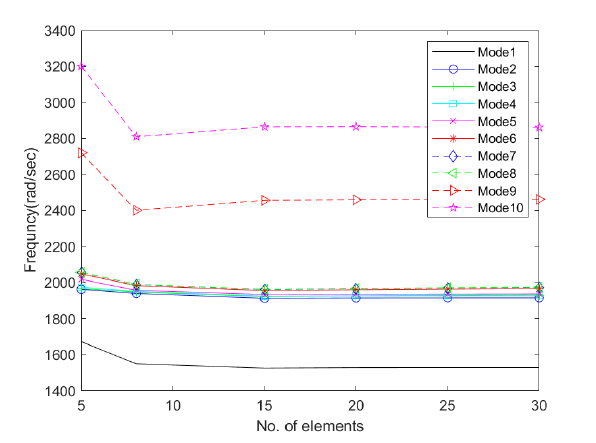
Figure 6. Convergence of natural frequencies of the modular morphing wing with hinged ends.